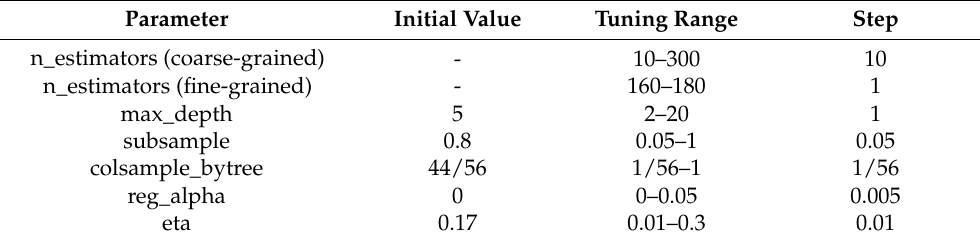
Table 5. Adjustment process of important parameters of XGBoost.